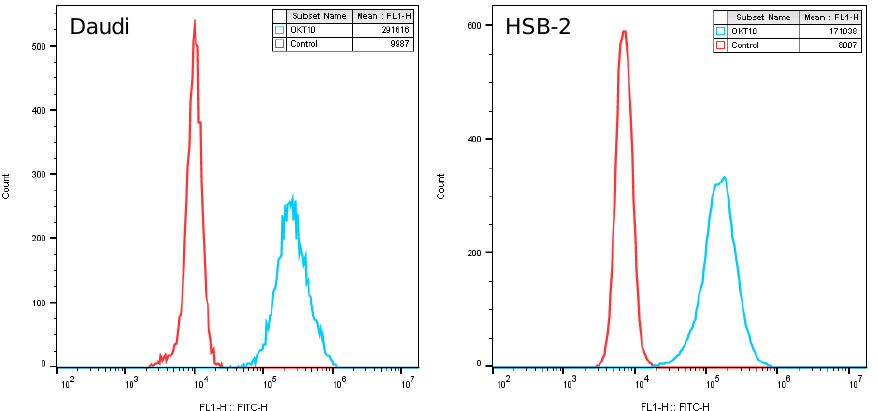
Figure 1. Expression of CD38 on Daudi and HSB-2 cells. Flow cytometry was used to assess the expression of CD38 on the surface of Daudi and HSB-2 cells by binding to the anti-CD38 antibody OKT10. Negative controls are presented for comparison.